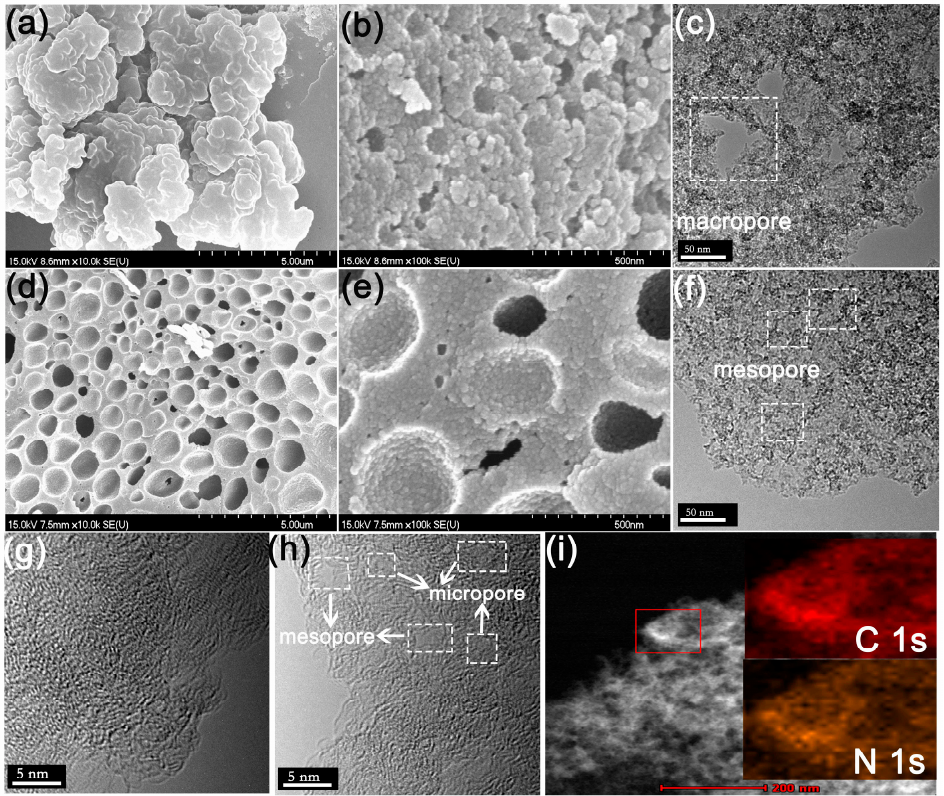
Figure 1. SEM images of the CA ( a , b ) and N-CA ( d , e ); TEM images of the CA ( c ) and the N-CA ( f